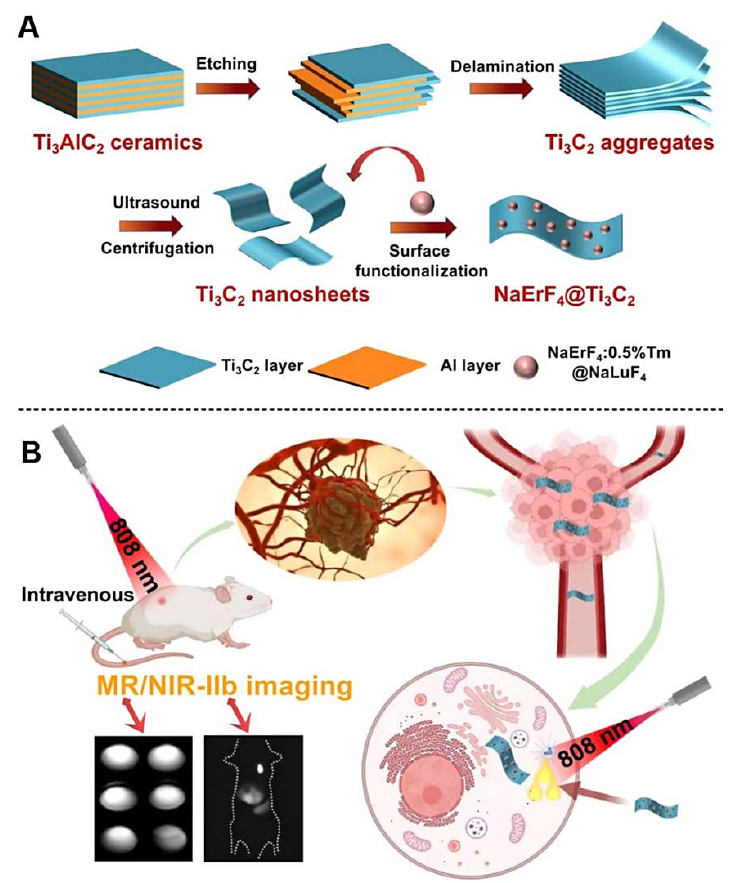
Figure 4. ( A ) The preparative process of NaErF 4 @Ti 3 C 2 MXene-based nanosystems for cancer theranostic applications. ( B ) Photothermal therapy and MR/NIR-II b imaging of cancer/tumor using the MXene nanocomposites. Adapted from Reference [56] with permission. Copyright: 2022, American Chemical Society.